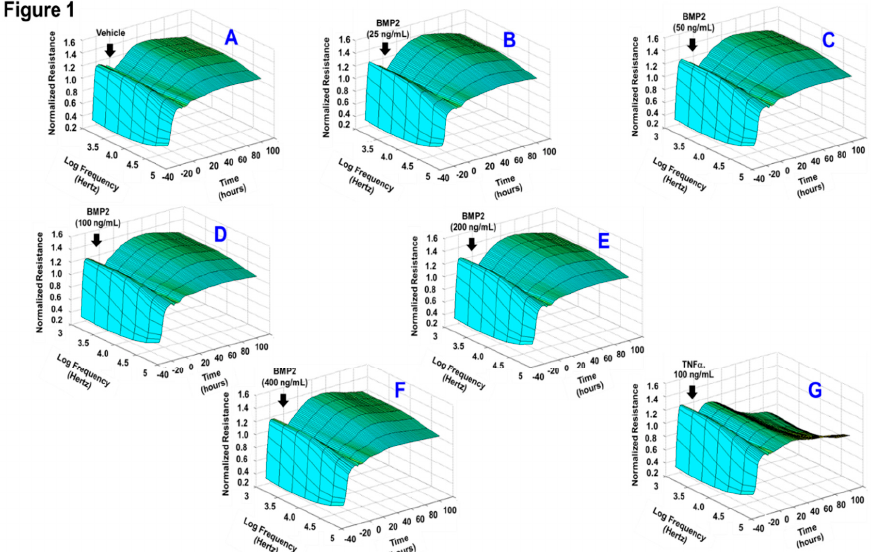
Figure 1. Three-D model representation for the effect of bone morphogenetic protein (BMP)2 on ARPE-19 barrier functionality. By using a real-time monitoring of transepithelial electric resistance (TER) as an indicator of barrier integrity, BMP2-treatment was initiated after ARPE-19 cells formed confluent mature monolayersindicated by the plateau in TER, y -axis shown in the representative 3D model. Thereafter, monolayers of ARPE-19 cells were treated with BMP2 at different concentrations (0, 25, 50, 100, 200, or 400 ng/mL; ( A – F ), respectively) and the barrier integrity was monitored over a 100-h period (represented on the z -axis) as well as across 9 frequencies (250, 500, 1000, 2000, 4000, 8000, 16,000, 32,000, and 64,000 Hz, represented as log values on the x -axis). As shown in ( A – F ), BMP2 did not affect the barrier integrity of ARPE-19 at any of tested concentration compared to the positive control cells, which were treated with TNF α at 100ng/mL ( G ); n = 4–6.